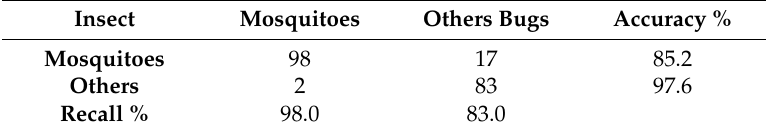
Table 3. The result of the classification of mosquitoes and others bugs using SVM II.